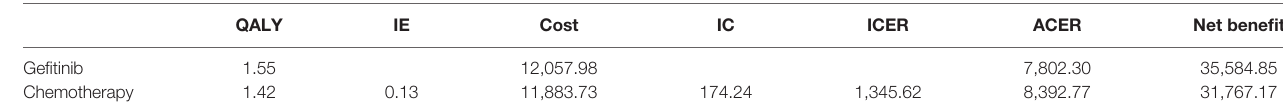
TABLE 3 | Results. QALY IE